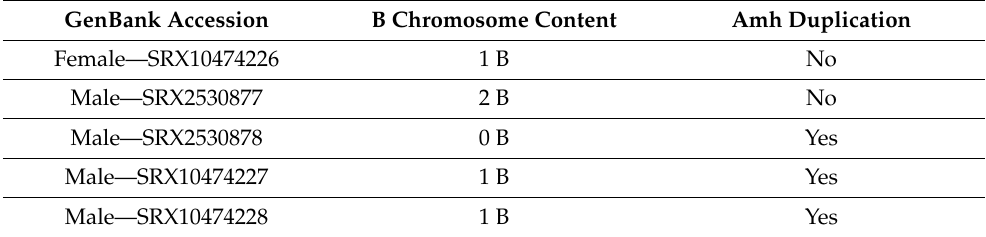
Table 1. Occurrence of an amh gene duplication in H. latifasciatus from whole genome